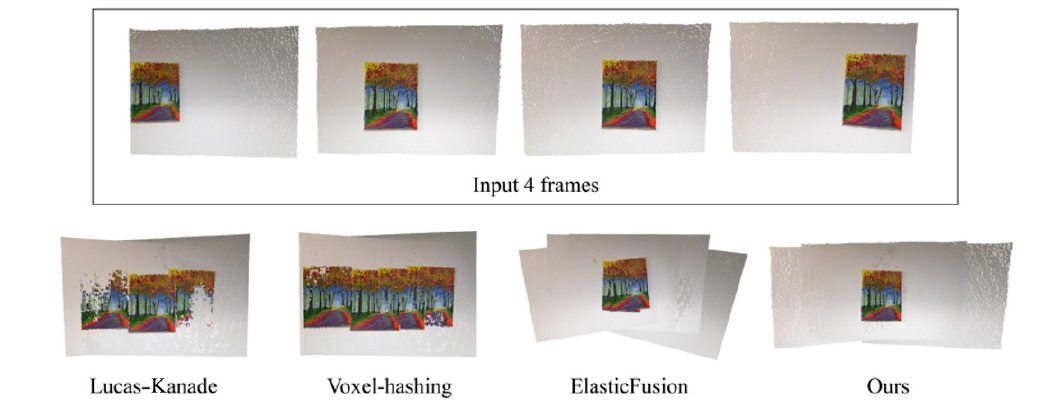
Fig. 1 Camera pose estimation comparison between methods. Top: four real input point clouds scanned using different views of a white wall with a painting. Bottom: results of stitching using camera poses provided by the Lucas–Kanade method [6], voxel-hashing [2], ElasticFusion [9], and our